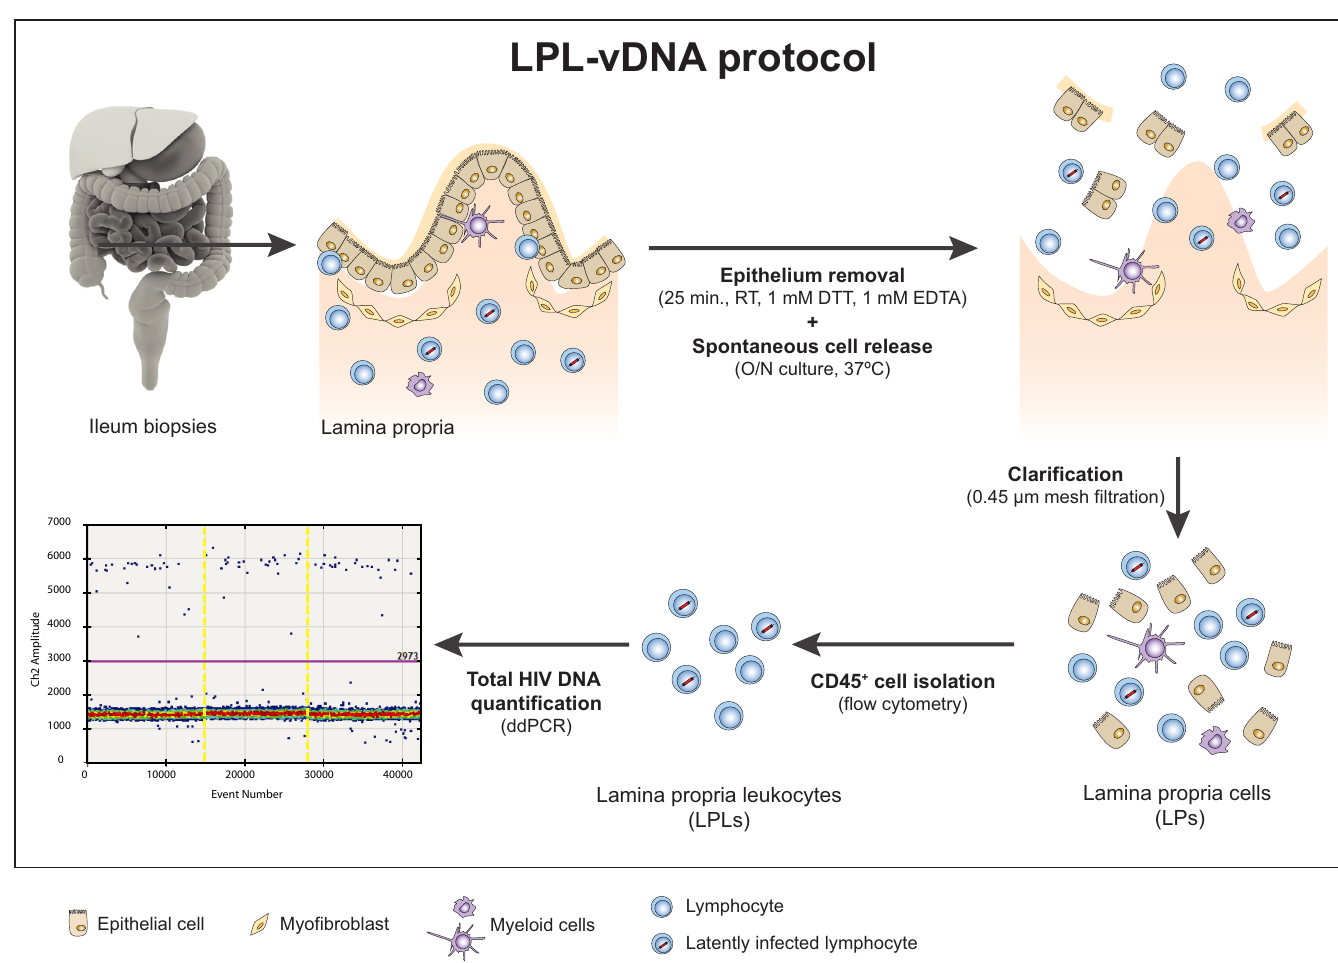
Fig 1. Schematic representation of the LPL-vDNA assay. The cells in blue representlymphocyte populations and in purple, myeloidpopulations. LPs: laminapropriacells; LPLs: lamina proprialeukocytes; O/N: overnight; ddPCR: dropletdigital PCR.